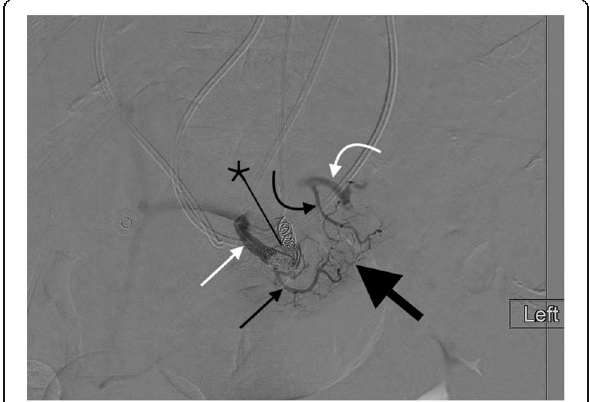
Fig. 8 Schematic representation of collateral pathway of right gastroepiploic (thick curved black arrow) to left gastroepiploic artery (thin curved black arrow). The right gastroepiploic artery is a terminal branch of the gastrodoudenal artery (GDA; straight white arrow). It courses within the greater omentum along the greater curvature of the stomach. The left gastroepiploic artery may arise from the distal splenic or an inferior polar artery